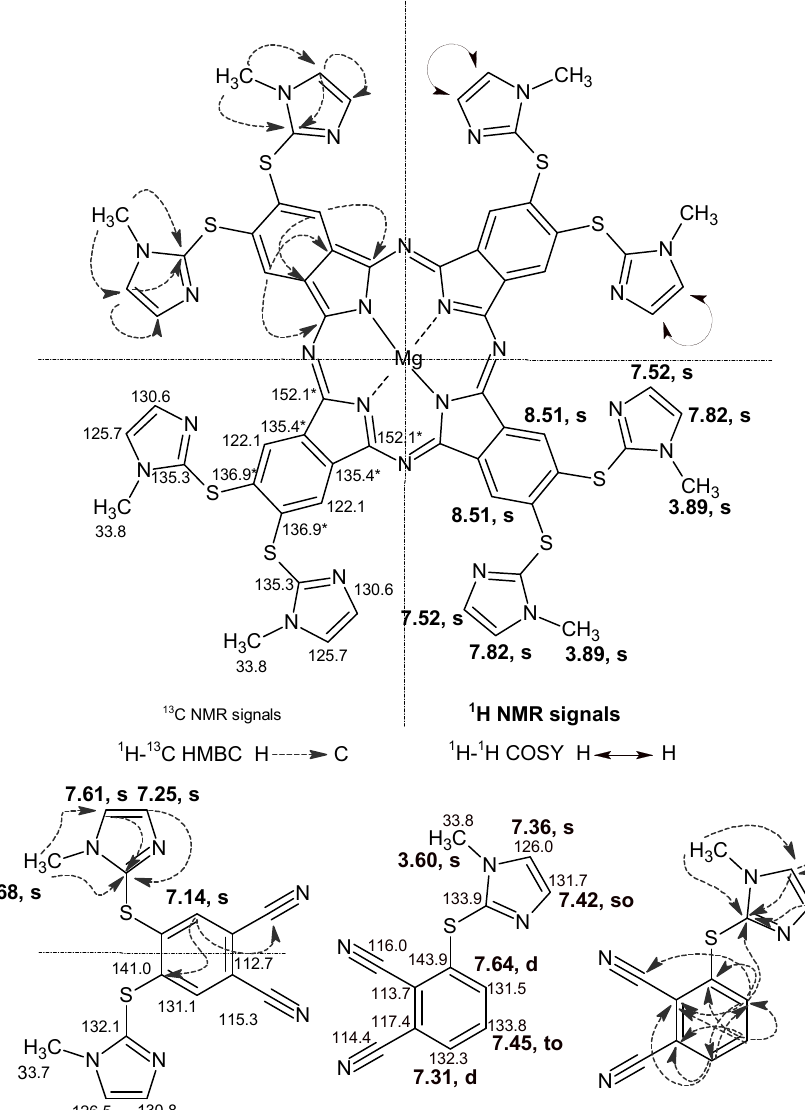
Figure 3. Signal annotations of 1 , 2 and 7 in DMSO- d 6 from 1 H, 13 C, 1 H– 1 H COSY, 1 H– 13 C HSQC, 1 H– 13 C HMBC spectra and the GIAO computational method (marked by an asterisk).